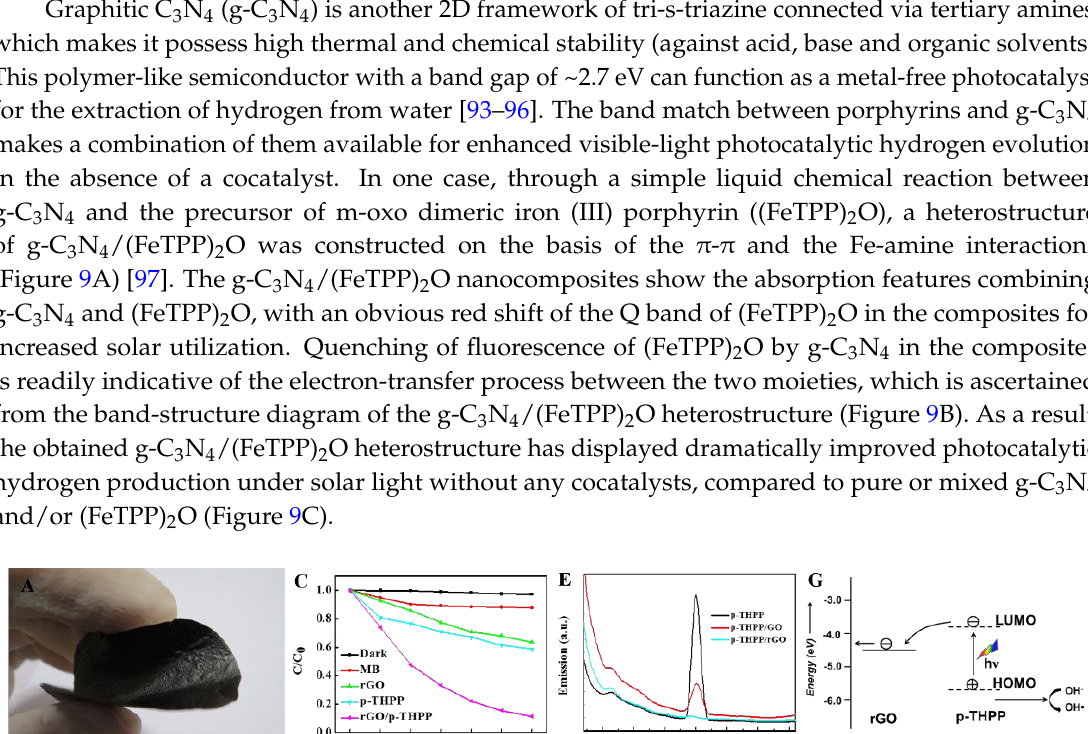
Figure 9. ( A ) SEM image of the graphitic C 3 N 4 (g-C 3 N 4 )/m-oxo dimeric iron (III) porphyrin ((FeTPP) 2 O) heterostructure including 5 wt% (FeTPP) 2 O; ( B ) The band-structure diagram of the g-C 3 N 4 /(FeTPP) 2 O heterostructure; ( C ) photocatalytic H 2 production rates over pure (FeTPP) 2 O, the g-C 3 N 4 + (FeTPP) 2 O (5 wt%) mixture and g-C 3 N 4 /(FeTPP) 2 O (5 wt%). Reproduced with permission from [97]. Copyright 2016, Royal Society of Chemistry.